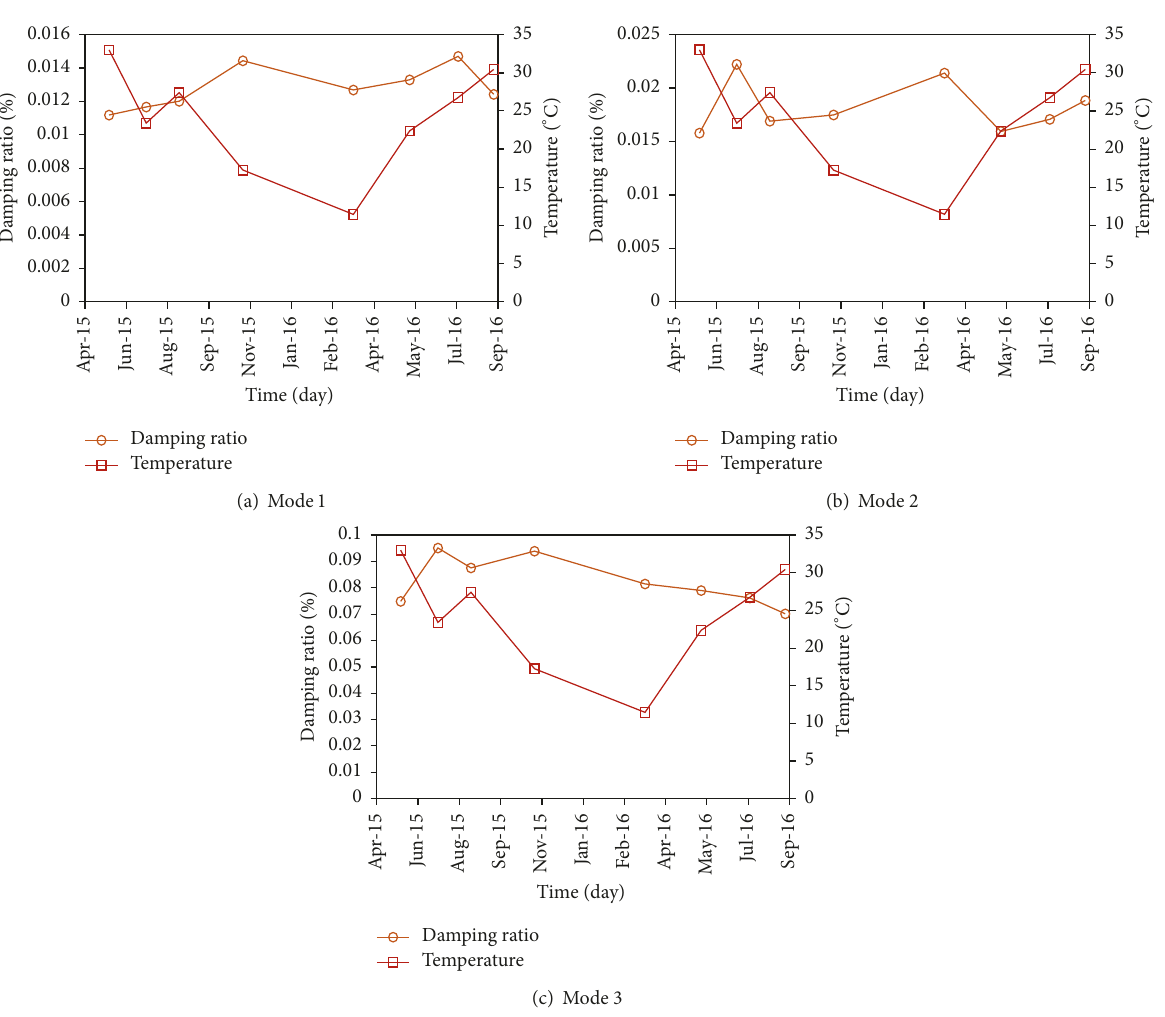
Figure 16: ((a)–(c)) Variations in average damping ratios of girder No. 3 over one and a half years.